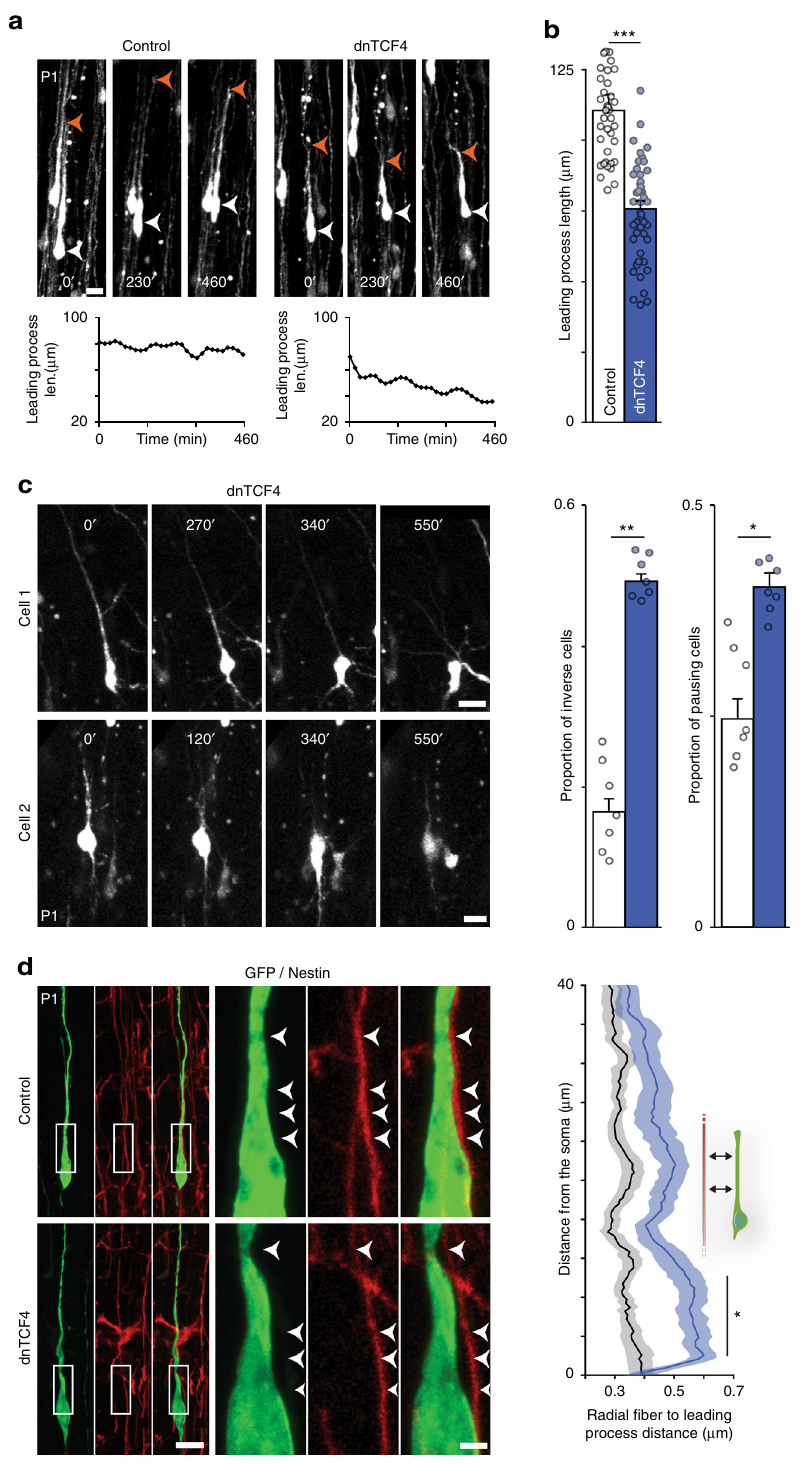
Fig. 2 Loss of Wnt canonical signaling alters leading process stability and CPN attachment to radial glia. a Confocal time lapse sequence of representative control and dnTCF4 electroporated cells migrating in the cortical plate (CP). Graphs show dynamics of leading process length over time measured in the cells depicted. b Post hoc analysis of confocal images indicates that the leading process of dnTCF4 cells appears shorter than that of controls; n = 50 cells/ condition from 7 brains, Student ’ s t test. See also Supplementary Movie 3. c Confocal time lapse sequences of two representative dnTCF4 cells migrating in the CP showing the frequently observable event of leading process inversion. Graphs represent the percentage of tracked cells exhibiting leading process inversion at least once (inverse cells) and the percentage of tracked cells remaining stationary for at least 100 min (pausing cells); n = 7 brains, Mann – Whitney. See also Supplementary Movie 4. d Representative images illustrating migrating cells attached to nestin-positive radial glia fi bers. Note the increased space between the leading process of dnTCF4 electroporated cell and the glia fi ber (arrowheads). We performed point-by-point measurement of the distance between the leading process of migrating cells and the radial fi ber; n = 50 cells/condition from 4 brains, two-way ANOVA. Graphs display mean ± s.e.m. * P < 0.05, ** P < 0.01, *** P < 0.001. Bars = 2 µ m ( d , close up) and 20 µ m ( a , c , d